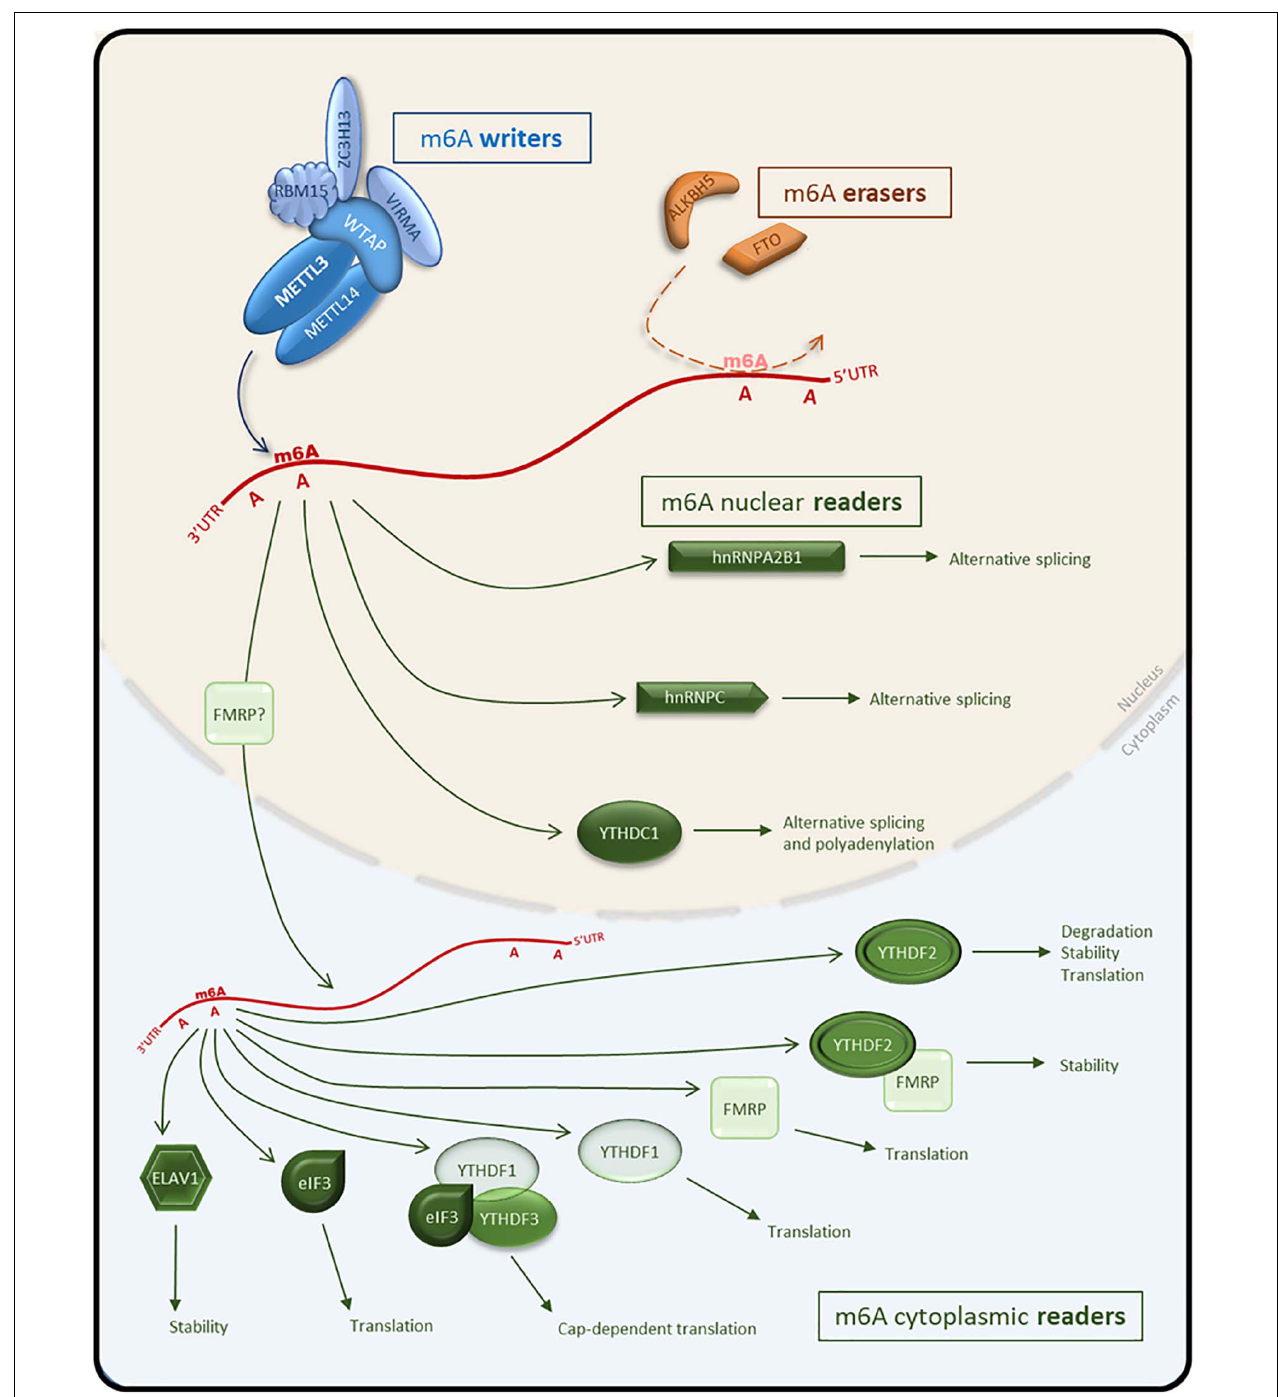
FIGURE 1 | Schematic representation of the m 6 A pathway and effectors on mRNA. The MACOM complex composed of m 6 A writers (METTL3, METTL14, WTAP, VIRMA, ZC3H13, and RBM15) deposits m 6 A on target RNAs. M 6 A erasers (FTO and ALKBH5) remove the m 6 A mark. M 6 A nuclear readers (hnRNPC, hnRNPA2B1, and YTHDC1) facilitate alternative splicing or polyadenylation following recognition of m 6 A-tagged RNA. M 6 A-tagged RNA can be exported to the cytoplasm and bound by cytoplasmic readers (eIf3, ELAVL1, YTHDF1,2,3) to modulate stability, translational efficiency or the degradation of RNA. Blue, m 6 A writers; Orange, m 6 A erasers; Green, m 6 A